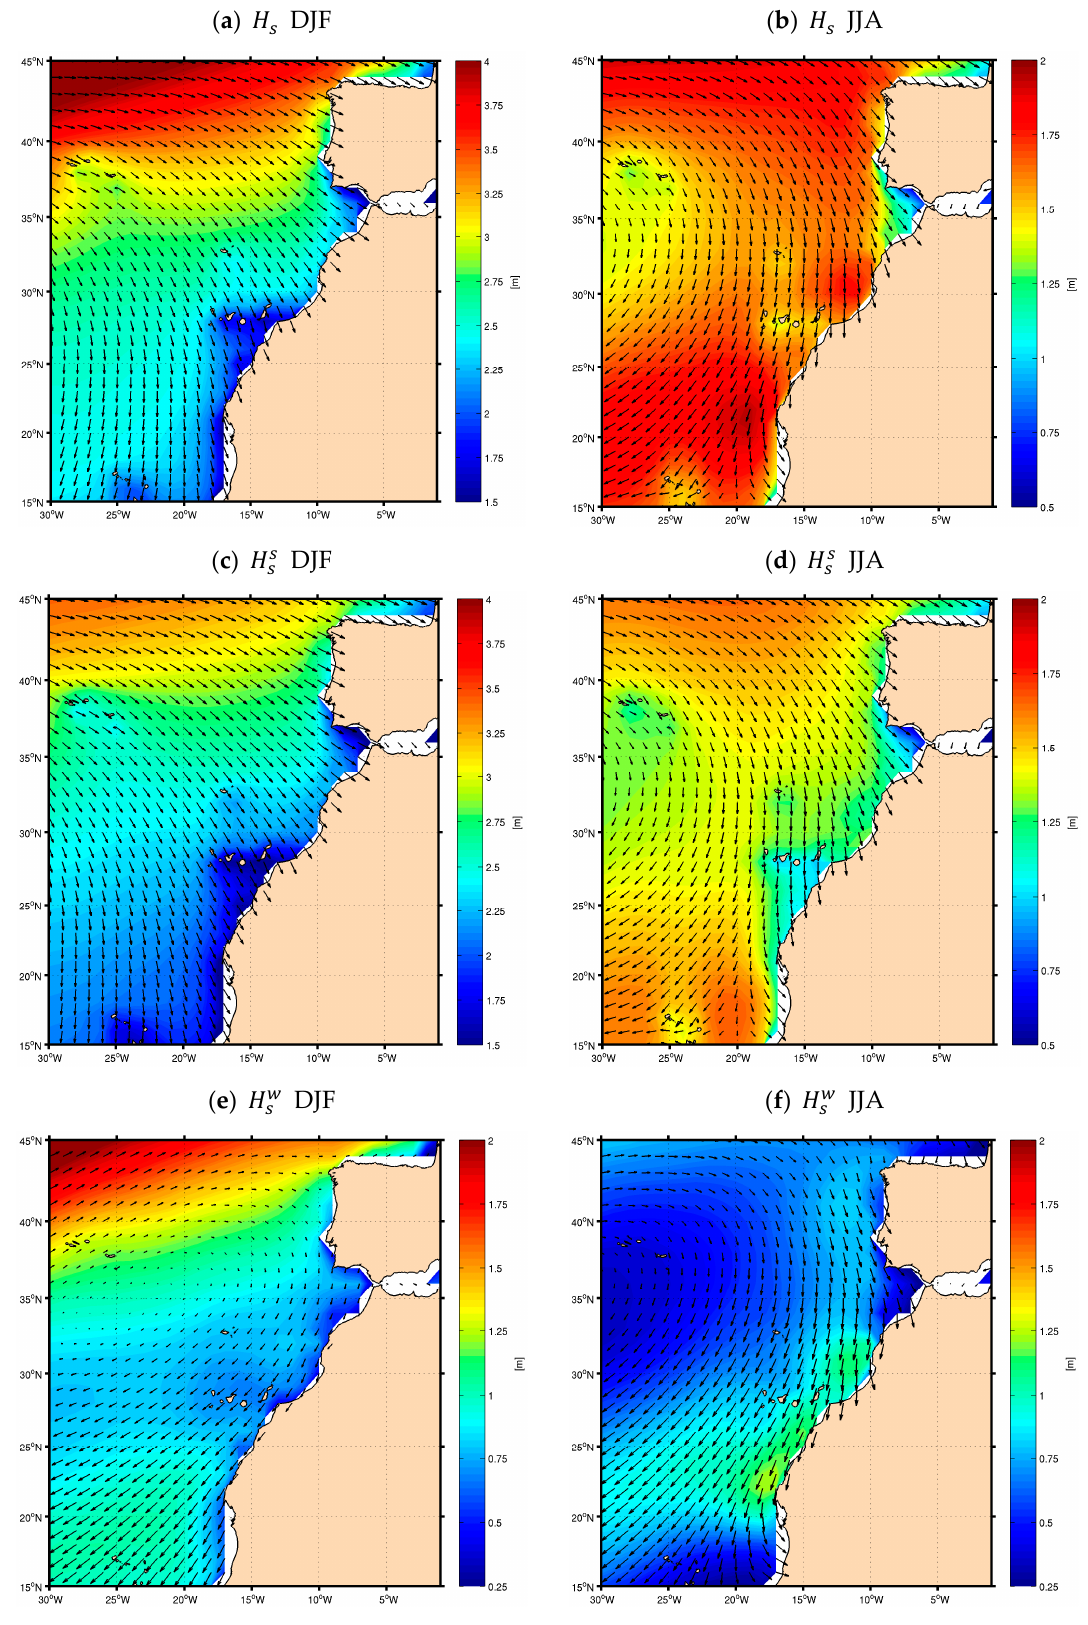
Figure 4. Climatological averages of H s (m) for ( a ) DJF and ( b ) JJA, of H s s (m) for ( c ) DJF and ( d ) JJA, and of H w s (m) for ( e ) DJF and ( f ) JJA, as well as of θ s ( ◦ ), θ s s ( ◦ ), and θ w s ( ◦ ) for the corresponding seasons. The arrows are scaled with the corresponding background fields, and the color scales vary between the different panels.